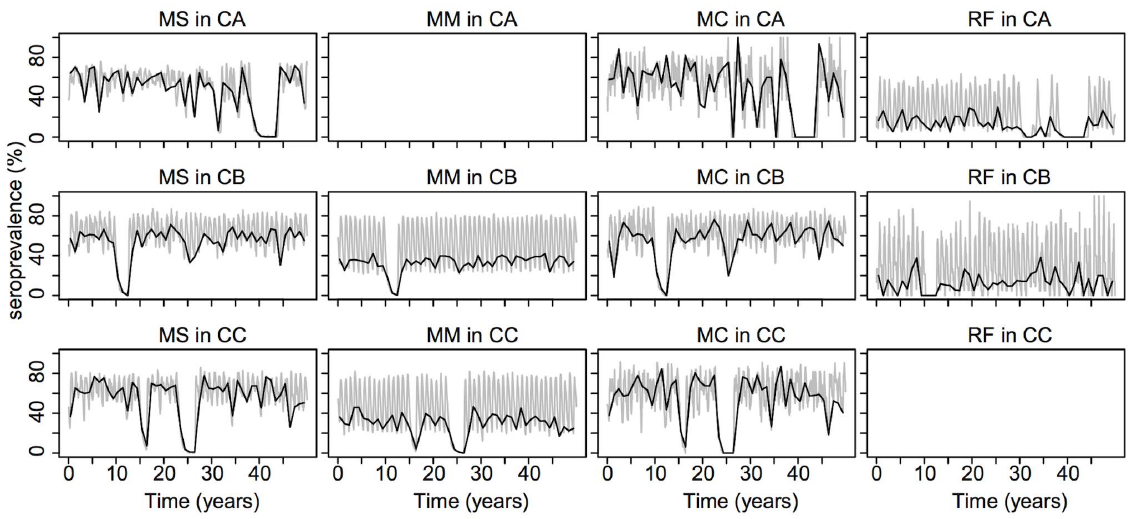
Figure 5. One model simulation run. Gray lines correspond to anti-EBLV-1 antibody seroprevalence in each subpopulation over 50 years. Black lines correspond to seroprevalence measured at the end of May. The parameter values used are: R 0 =3, r =0.6, interisland exchange =3 individuals, immune-period duration =6 months, and the default values reported in Table 2 for the incubation- and immune-period durations. Abbreviations are as given in the legend to Figure 3.